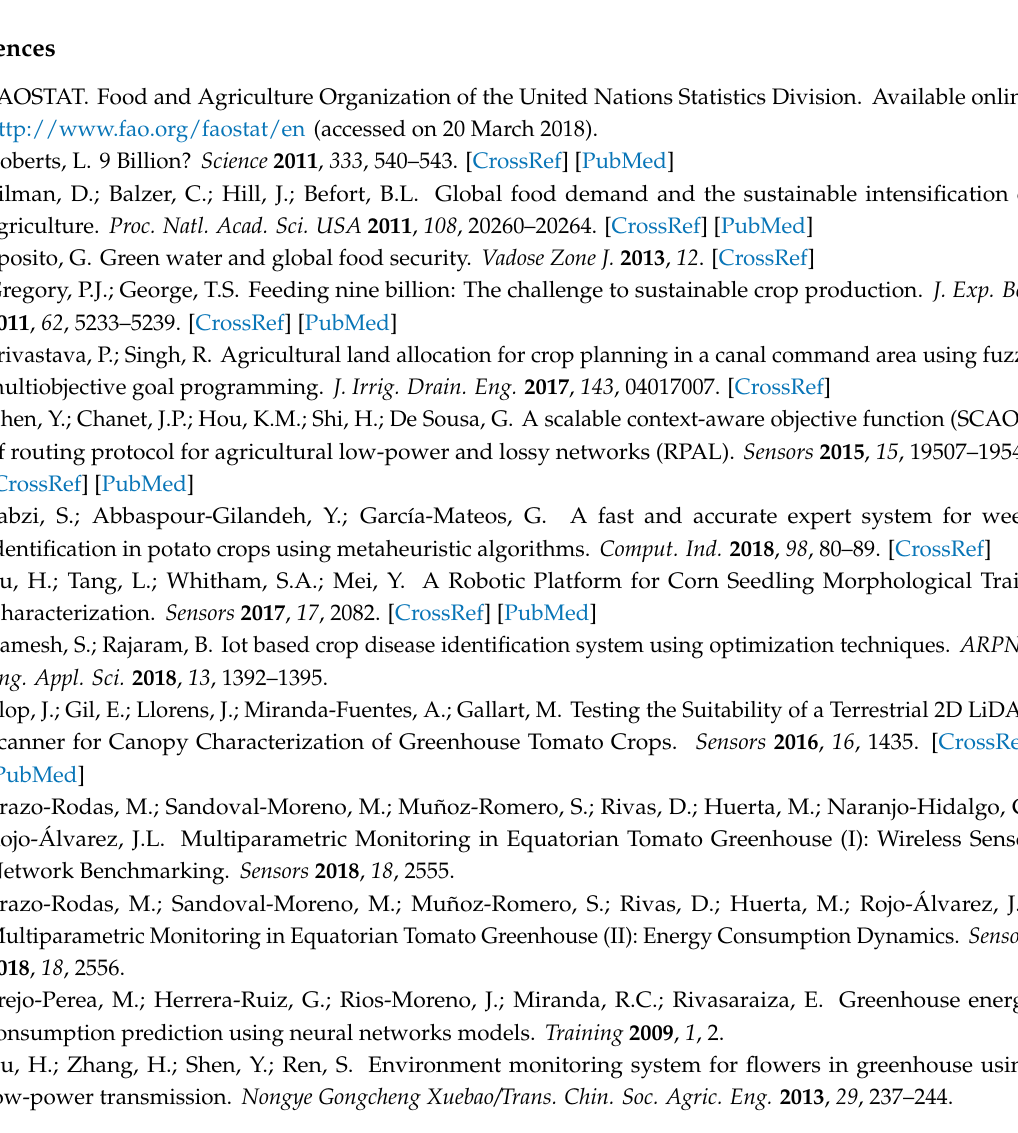
Figure A4. Modeling the CO 2 signal in Sensor Node 4 of DigiMesh network. From top to bottom: Bland–Altman plots with Reg = 15 and Ord = 30; Reg = 15 and Ord = 100; Reg = 40 and Ord = 30,; and Reg = 40 and Ord =